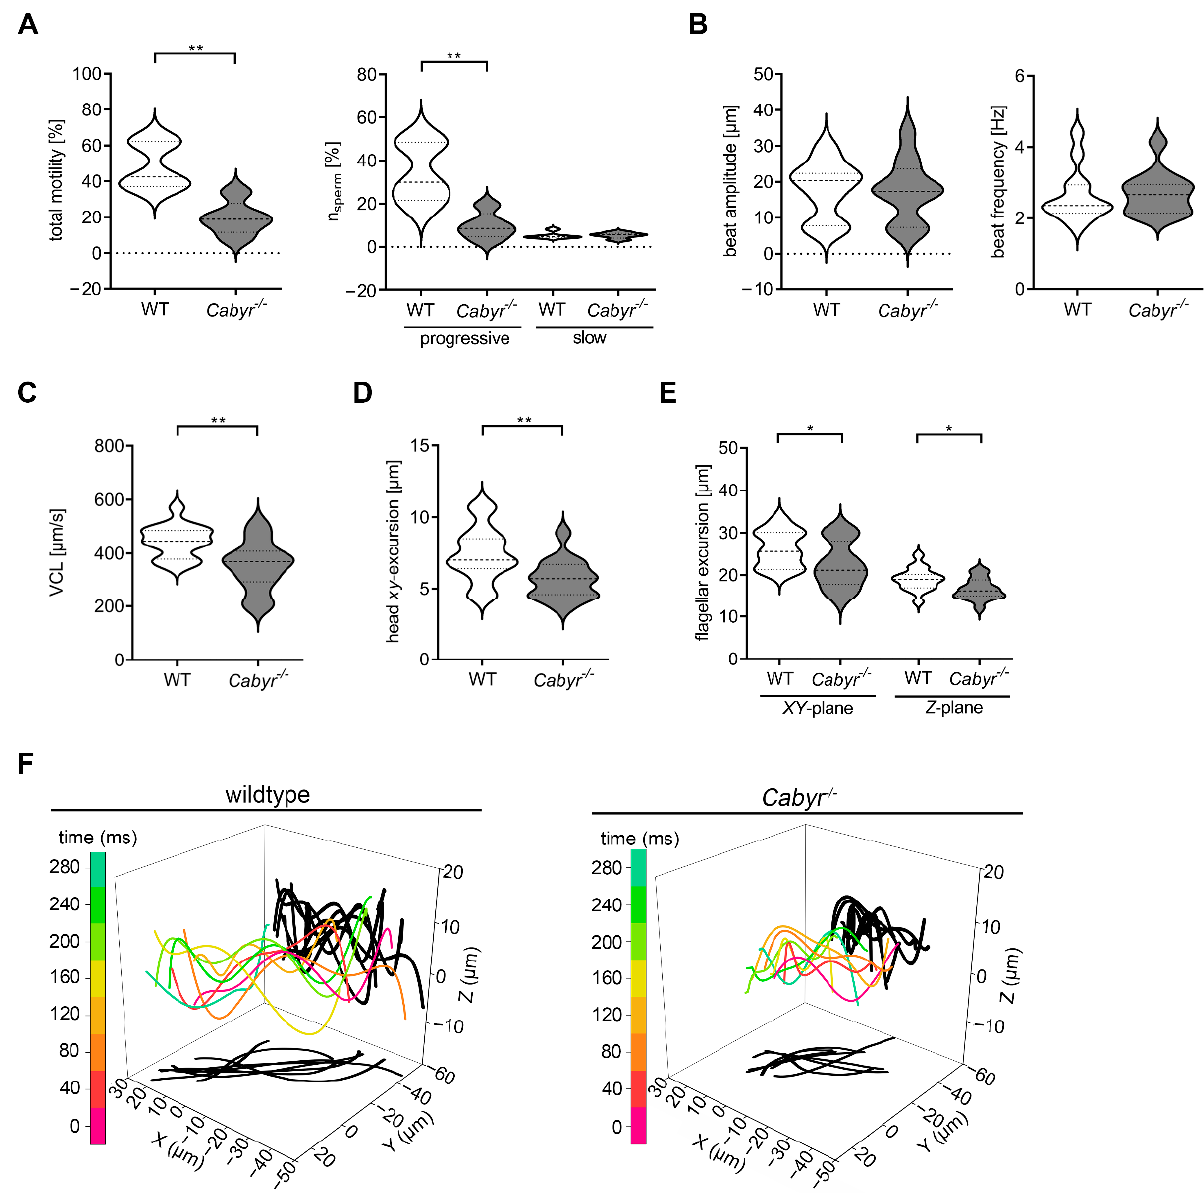
Figure 6. Cabyr–a Ca 2+ binding tyrosine-phosphorylation-regulated protein—is required for 4D sperm motility. ( A ) Computer-assisted sperm analysis (CASA) reveals decrease of motile sperm in Cabyr − / − mice (left), which correlates with a decrease in the number of sperm showing a progressive sperm movement (right). N = 4, n > 800 sperm. ( B ) Flagellar beat amplitude and beat frequency analyzed by CASA are not affected by Cabyr knockout. N = 4, n = 15. ( C ) Statistical analysis of curvilinear velocity by DHM. N = 4, n = 15. ( D ) Statistical analysis of lateral head displacement of Cabyr knockout in comparison to WT sperm. ( E ) Analysis of flagellar excursion in XY - and Z -plane in Cabyr − / − sperm shows a decrease of flagellar movement. N = 4, n = 15. ( F ) Representative 4D flagellar excursions of wt (left) and Cabyr − / − (right) sperm in which 3D flagellar excursions at different time points (0, 40, . . . , 280 ms) are color-coded and its projection onto the XY - and Z -plane are shadowed in black. * p < 0.05, ** p < 0.01, median: thick dashed lines; interquartile range: thin dashed lines.